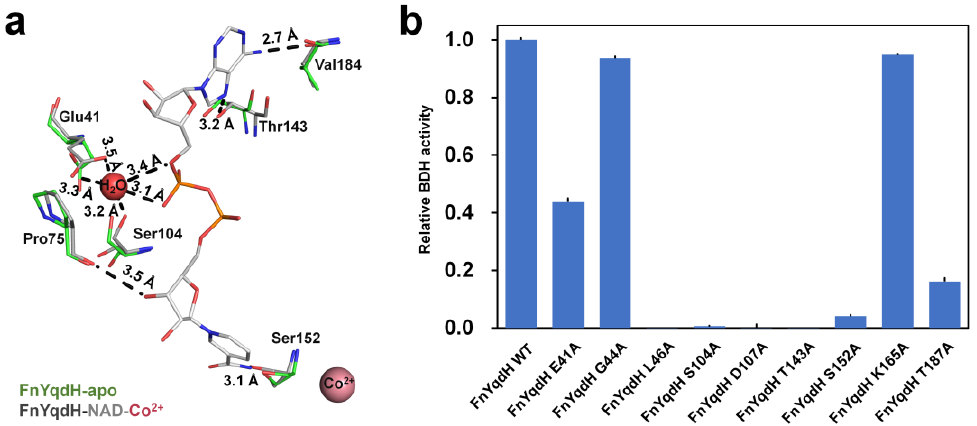
Figure 4. NADH-binding site in FnYqdH. ( a ) Superposition of the NADH-binding site in FnYqdH (green) and FnYqdH-NAD-Co 2+ (gray). ( b ) BDH activity of FnYqdH mutants for NADH-binding residues (E41A, G44A, L46A, S104A, D107A, T143A, S152A, K165A, and T187A). The activity of wild type FnYqdH (FnYqdH-WT) was defined as 100%.